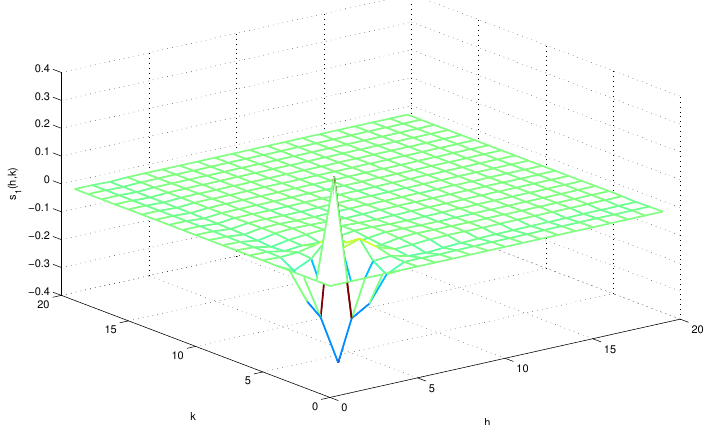
Figure 3. Sliding surface function component: s 1 .